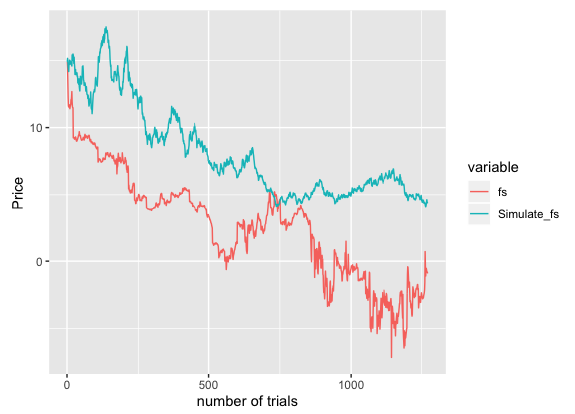
Figure 3. Simulation Result of IGBM model on fuel-switching data.